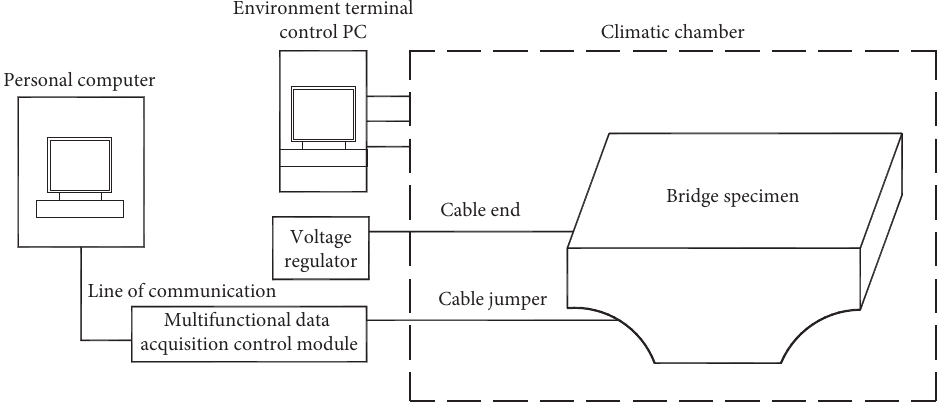
Figure 5: Experimental device for heating cable melting system.